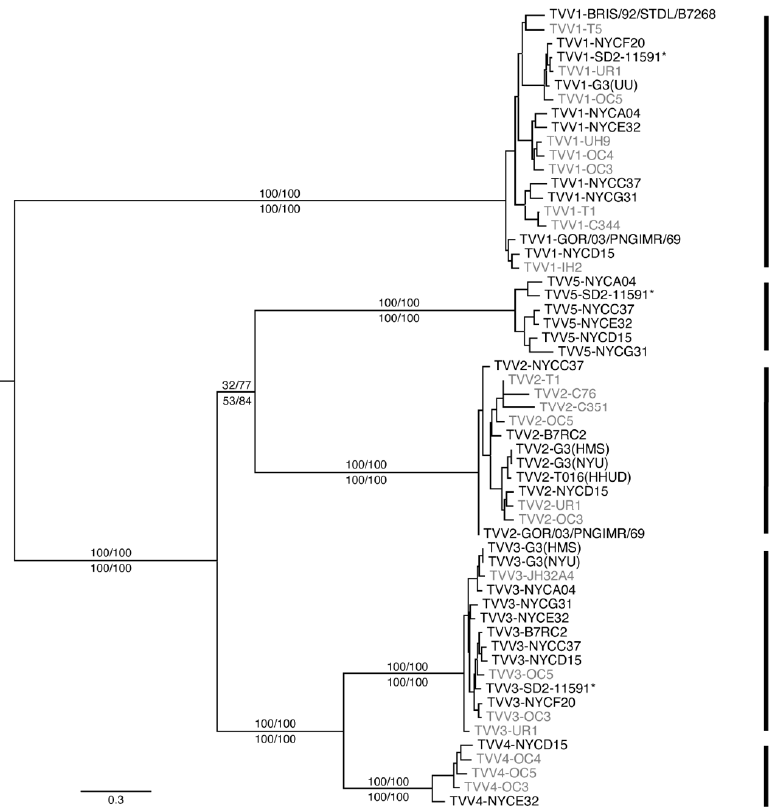
Figure 1. Maximum-likelihood phylogenetic tree of TVV1 through TVV5 strains. CP/RdRp aa sequences were deduced from the new TVV assemblies presented in this study (labeled in black) as well as from reference TVV genomes retrieved from NCBI GenBank (labeled in gray). Support values for the main branches are shown as percentages; above the branch is the value from standard bootstrapping with/without subsequent transfer analysis, and below the branch is the value from ultrafast bootstrapping with/without subsequent transfer analysis. The tree is rooted at the midpoint. Bars on the right highlight the five trichomonasvirus species. See Table 1 and Supplementary File S2 for explanations of TVV strain names.